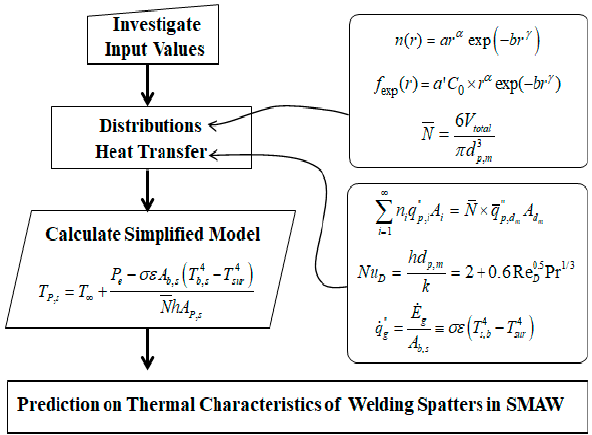
Figure 7. Calculation process of the prediction model.